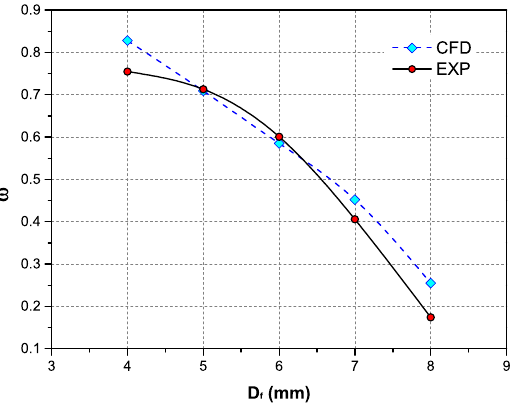
Figure 11. Comparison of predicted results and experimental data for ω with different D f .